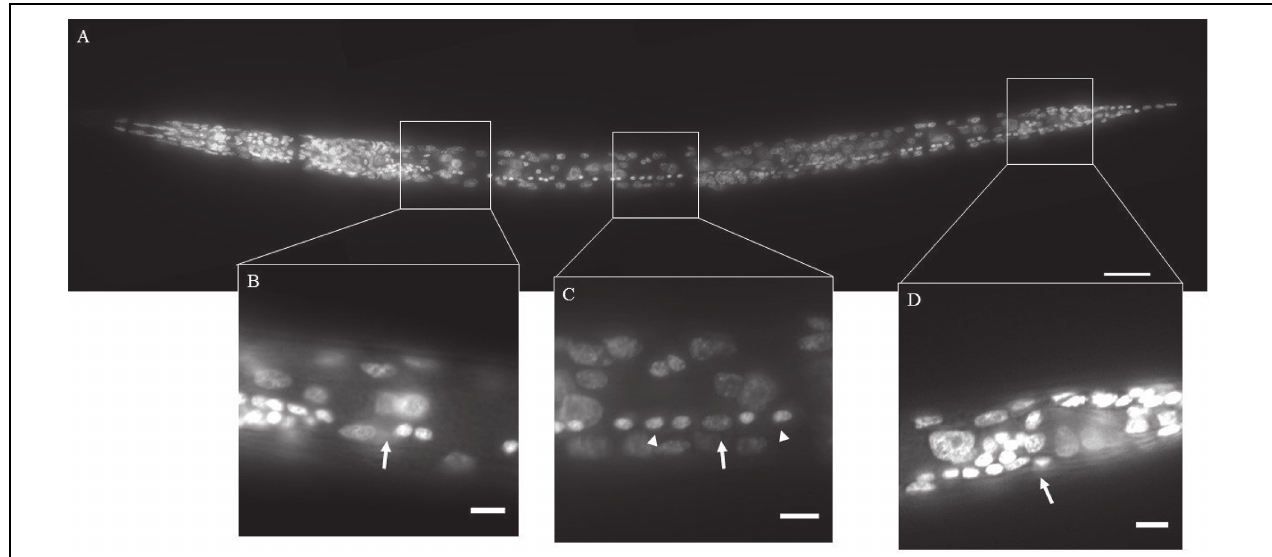
FIGURE 2 | DAPI staining of wild-type Caenorhabditis elegans (Clade 9). The ventral nerve cord (VNC) consists of a line of motor neurons extending along the ventral midline from the retrovesicular ganglion (RVG) to the pre-anal ganglion (PAG). (A) Ventral view of DAPI stained animal. (B) Region surrounding end of RVG and anterior portion of VNC (arrow). (C) Part of the VNC showing neuronal (arrowheads) and hypodermal (arrow) nuclei. (D) Division between PAG and VNC (arrow). Inset scale bars = 5 µ